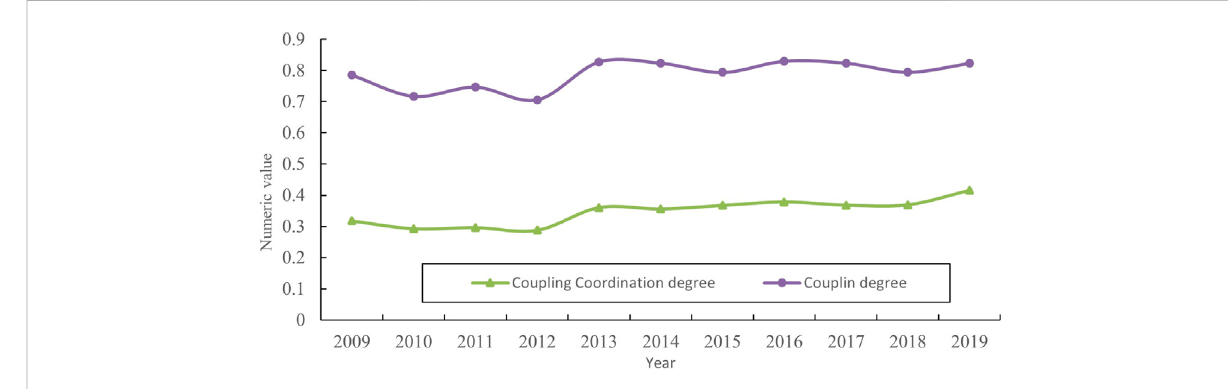
FIGURE 4 Coupling degree and coupling coordination degree of USFD and green economic development in the YREB from 2009 to 2019.